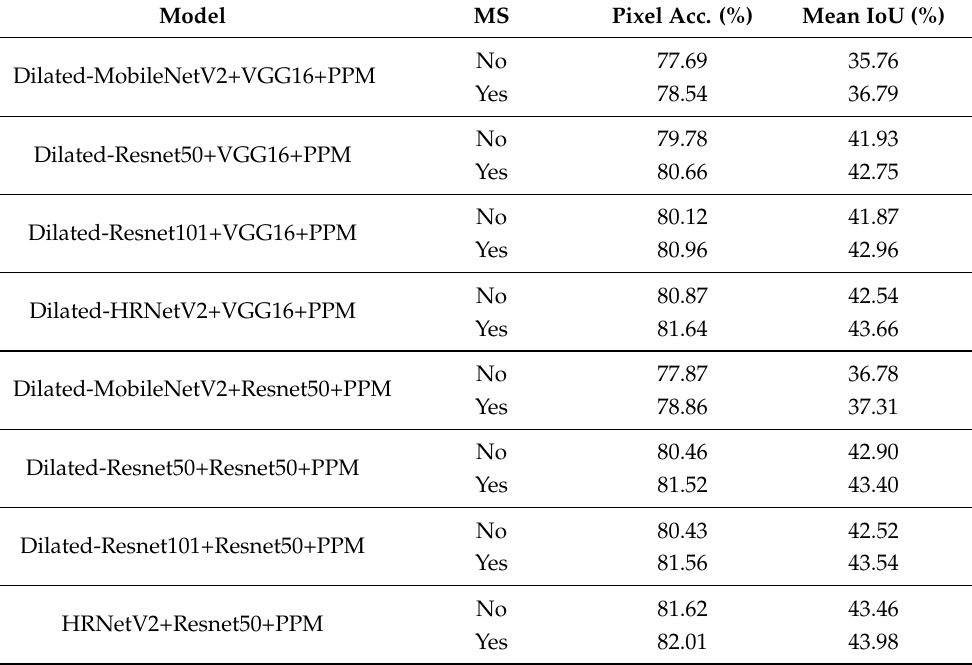
Figure 7. Segmentation results of DilatedResnet50+Resnet50+C1 and DilatedResnet50+Resnet50+ PPM. In the figure, C1 denotes that the decoder only consists of one convolution layer, and PPM denotes the decoder is a Pyramid Pooling Module. From left to right are: input images, ground- truth, the segmentation result of DilatedResnet50+ Resnet50+C1, and the segmentation result of DilatedResnet50+Resnet50+PPM. As can be seen from the part circled by the white circle in the figure, PPM can segment the object more completely, and the segmentation performance of object boundary is also better. Table 5. The comparison results of our models with/without multi-scale testing strategy. MS denotes the Multi-scale